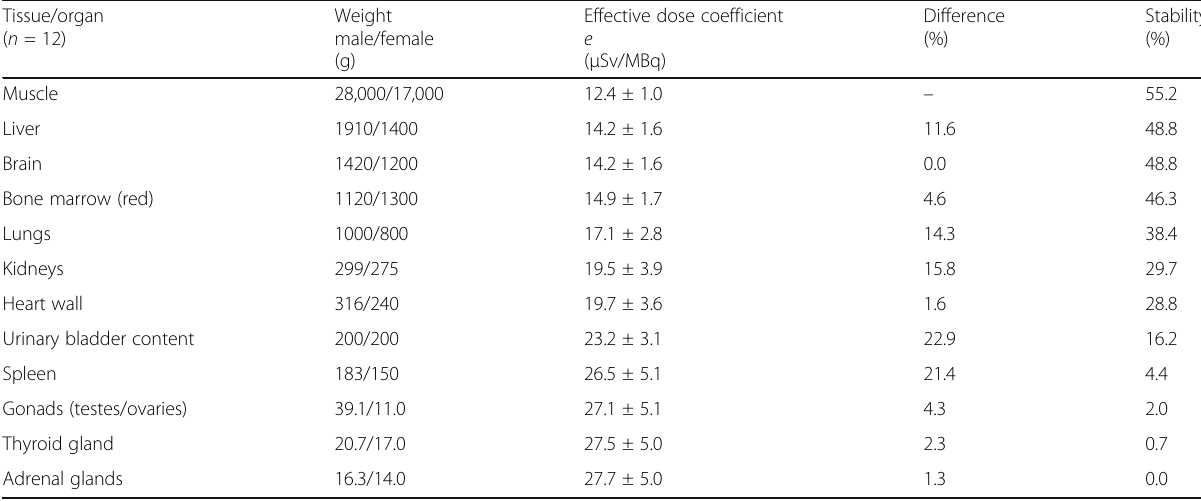
Table 5 Impact of number of tissues/organs included based on decreasing weight for CE stylized reference phantoms using ICRP Publication 60 tissue weighting factors, w T , to calculate the effective dose coefficient, e , with the SD. The difference in percent calculated according to Eq. 4 and stability according to Eq.